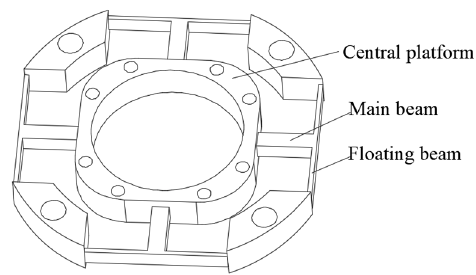
Figure 1. Overall structure of six-axis wrist force sensor.